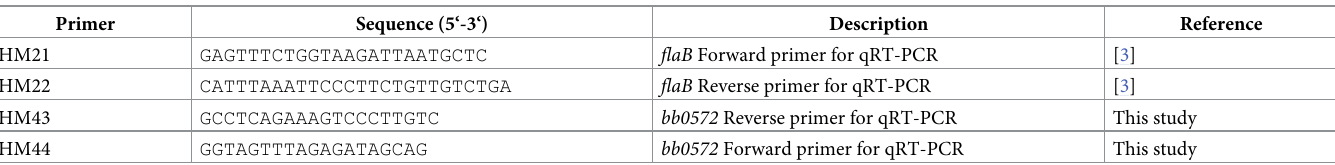
Table 1. Primers used in this